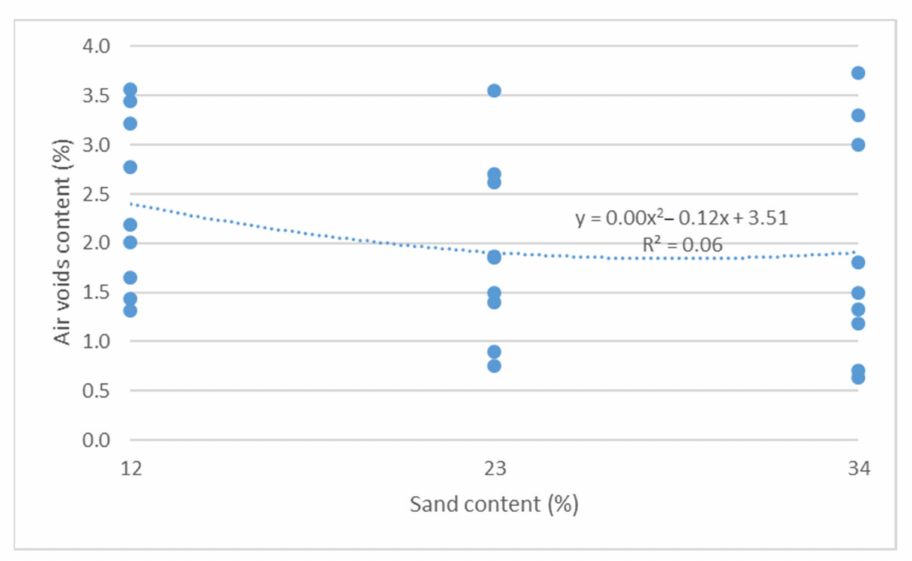
Figure 12. Air void content vs. crushed sand